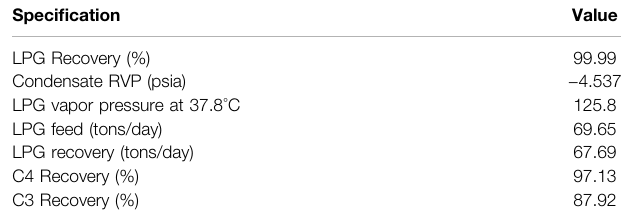
TABLE 2 | LPG product speci fi